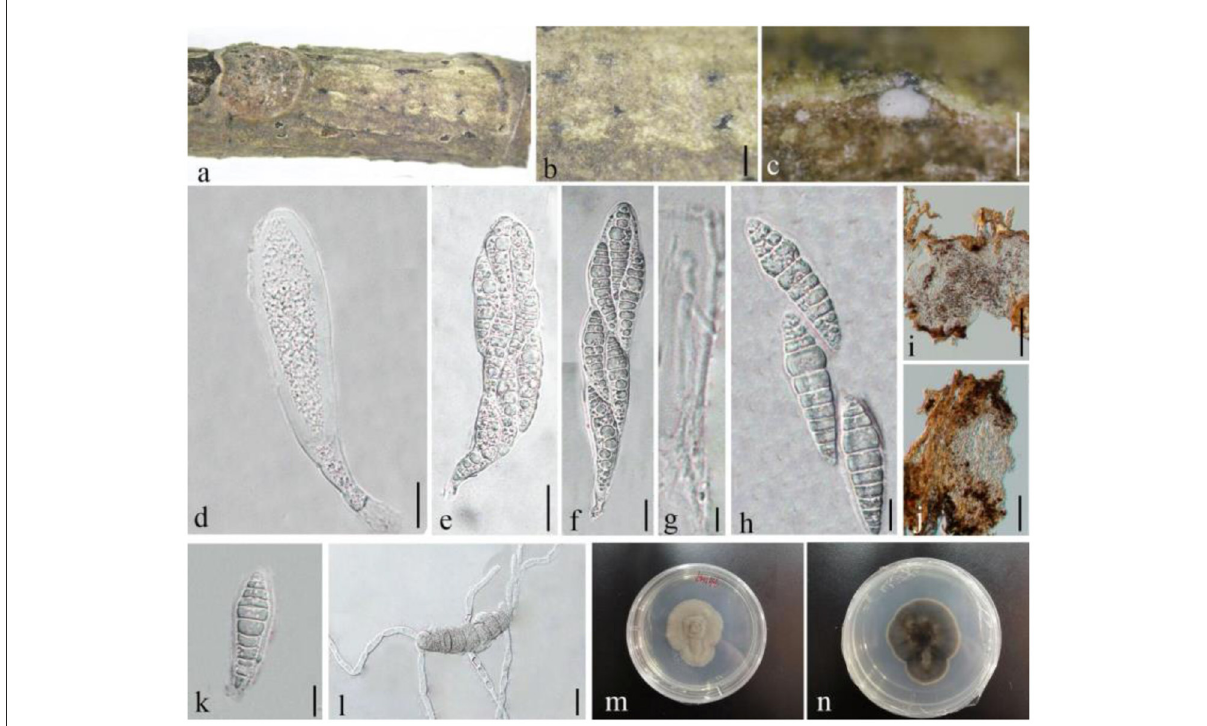
FIGURE8 Lonicericola qujingensis (GMB1386, holotype). (a) Dead branch of M. grandiflora . (b) Immersed ascomata on host. (c) Vertical section of ascoma. (d–f) Asci. (g) Pseudoparaphyses. (h,k) Ascospores. (i,j) Peridium. (l) Germinated ascospore. (m,n) Seven-day-old colonies incubated at 28 ◦ C on PDA. Scale bars: (b) = 500, (c,j) = 50, (d–f) = 20, (g,h,k,l) = 10, and (i) = 100 µ